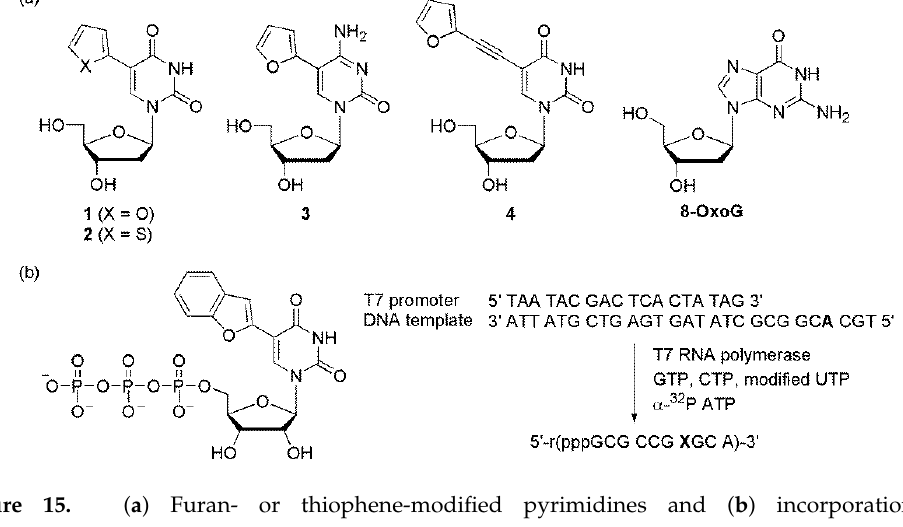
Figure 15. ( a ) Furan- or thiophene-modified pyrimidines and ( b ) incorporation of ribonucleoside